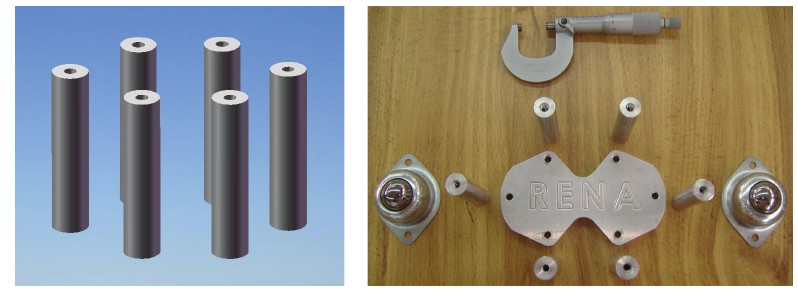
Figure 6: Ball-caster support.